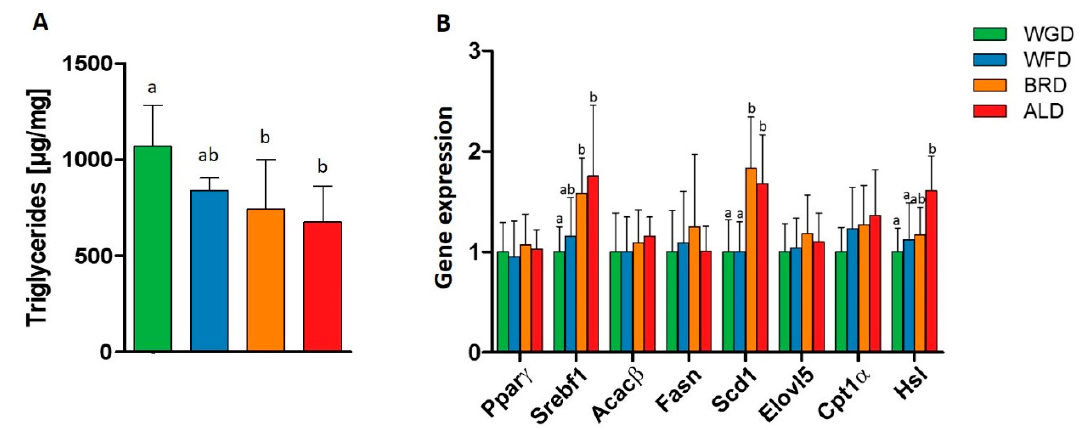
Figure 1. Liver triglyceride content ( A ), and liver gene expression of transcription factors and enzymes involved in liver lipid metabolism ( B ), in C57BL/6J mice fed with WGD, WFD, BRD, or ALD for 12 weeks. ab marked bars without a common letter differ significantly (p < 0,05). Data presented are mean ± SD. n = 7–8/group; ACAC- β : Acetyl-CoA Carboxylase β ; ALD: Aleurone supplemented